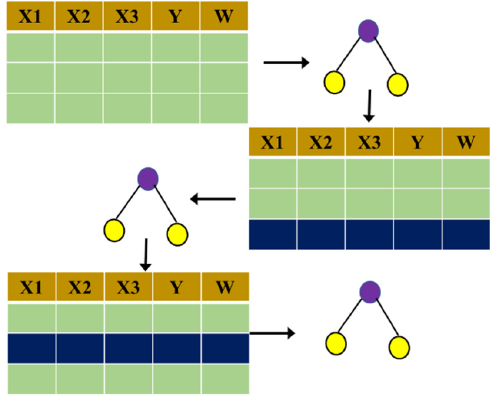
Figure 5. Schematic procedures of the AdaBoost classifier.